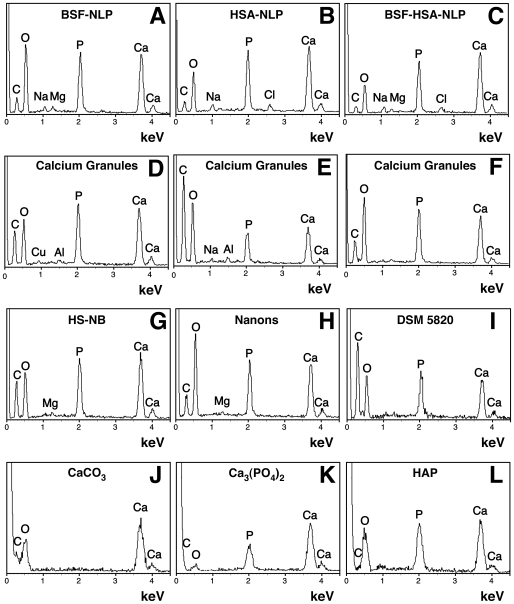
Energy-dispersive X-ray spectroscopy of protein-mineral nanoparticles shows elemental compositions indistinguishable from those of calcium granules and NB.Protein-mineral nanoparticles were obtained as in Fig. 9, from solutions containing BSF (A), HSA (B), or both (C), to which 0.3 mM each of CaCl2 and NaH2PO4 was added, followed by incubation in cell culture conditions for 1 month. EDX spectra were also obtained for calcium granules prepared by adding either CaCl2 (D), NaH2PO4 (E), or a combination of both (F) to FBS, followed by overnight incubation, centrifugation, and washing, as described in the
Materials and Methods
. NB were cultured from 10% HS (G, “HS-NB”) or from 10% FBS (H and I, corresponding to “Nanons” and “DSM 5820”, respectively). In these specimens, major peaks of carbon, oxygen, calcium, and phosphorus were noted, concordant with the presence of a calcium phosphate mineral containing carbonate. The three controls CaCO3 (J), Ca3(PO4)2 (K), and HAP (L), diluted and washed in double-distilled water, were shown for comparison. The following Ca/P ratios were obtained: (A) 1.37; (B) 1.53; (C) 1.6; (D) 1.32; (E) 1.48; (F) 1.14; (G) 1.48; (H) 1.4; (I) 1.27; (K) 2.54; and (L) 1.48. Phosphorus was not detected in the CaCO3 samples shown in (J).